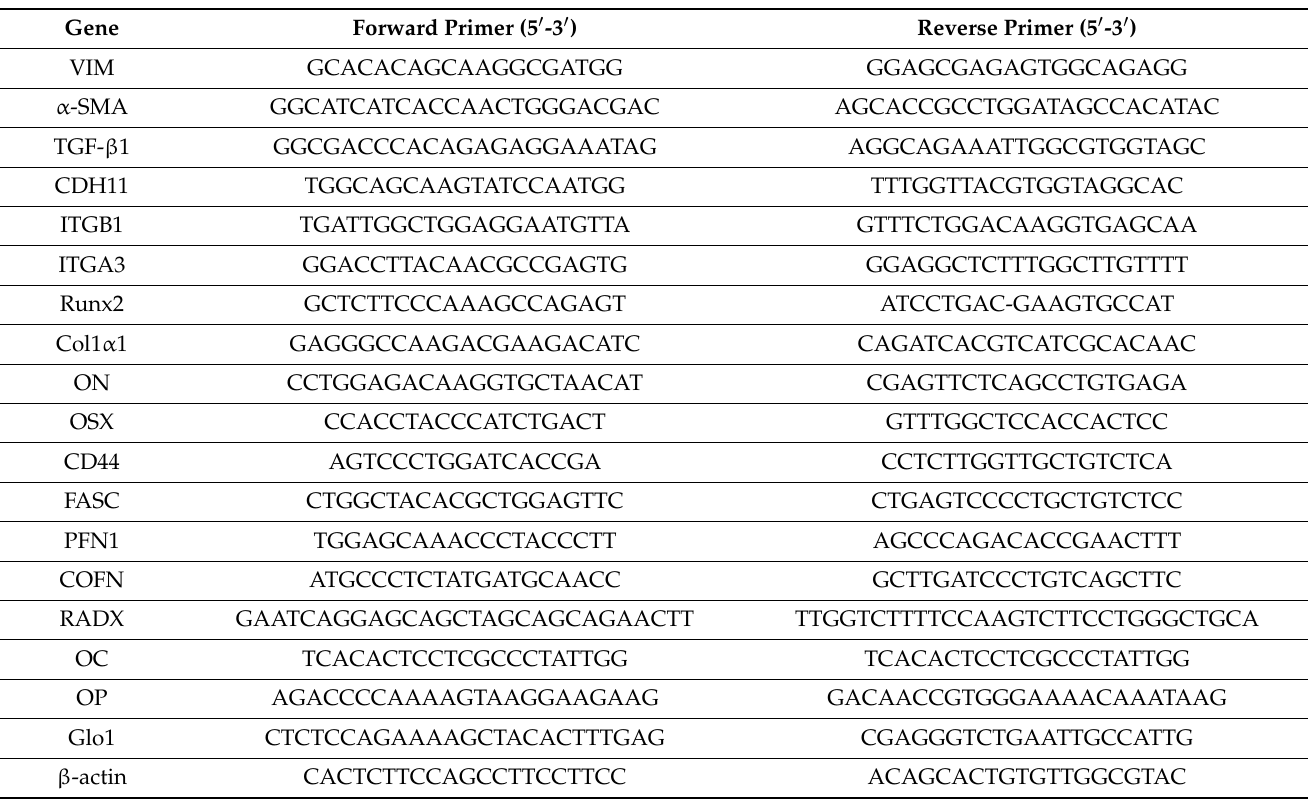
Table 1. Primers for